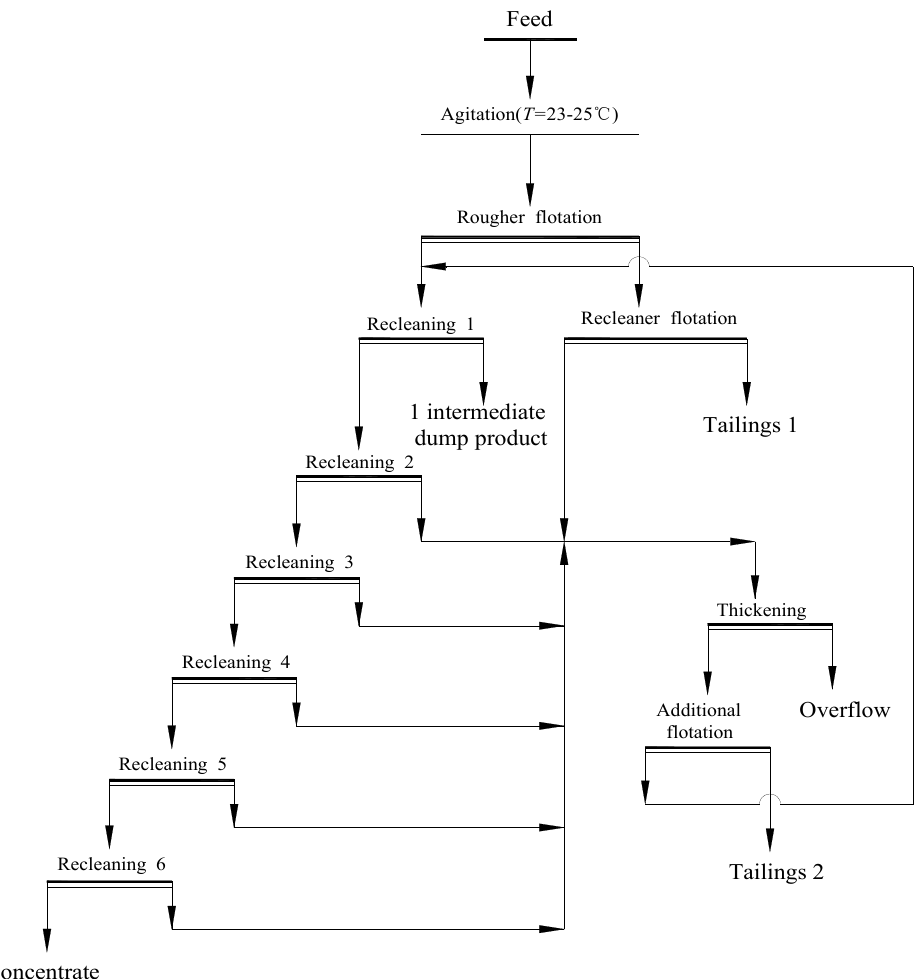
Figure 11. Updated flotation flowsheet.